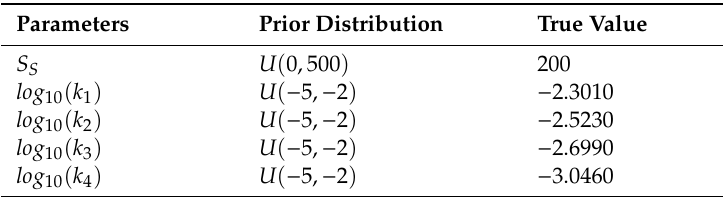
Table 2. The prior distributions and true values of the model parameters estimated in Case 1. U stands for the uniform